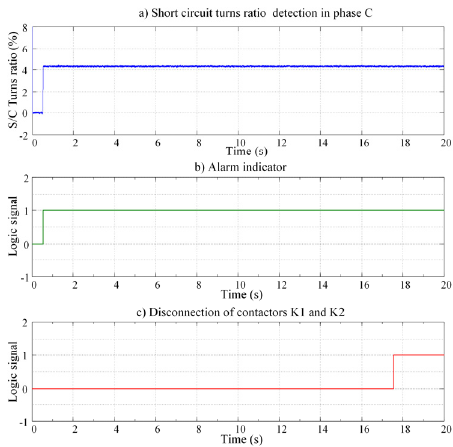
Figure 33. Scenario 1 Alarm indication and machine disconnection.